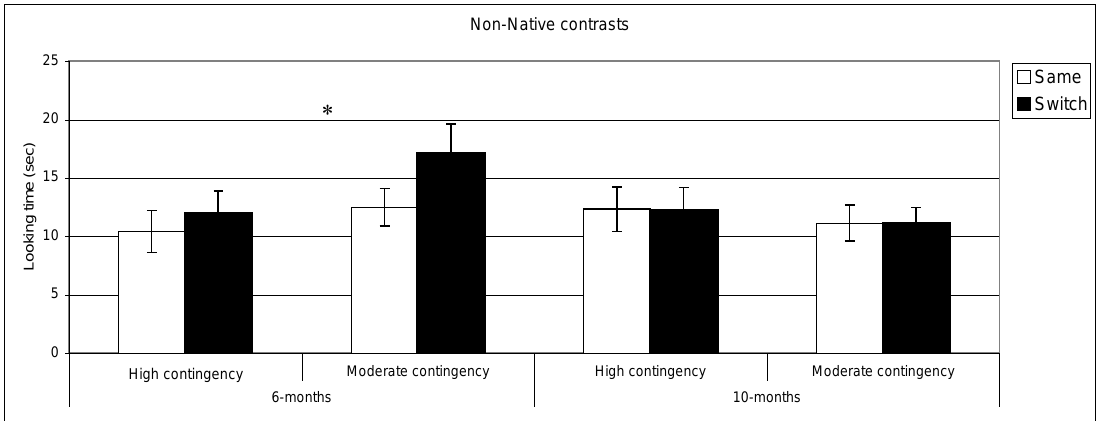
Figure 4. Looking time during same and switch trials for non-native contrasts at 6- and 10- months for subgroups of infants (* p <